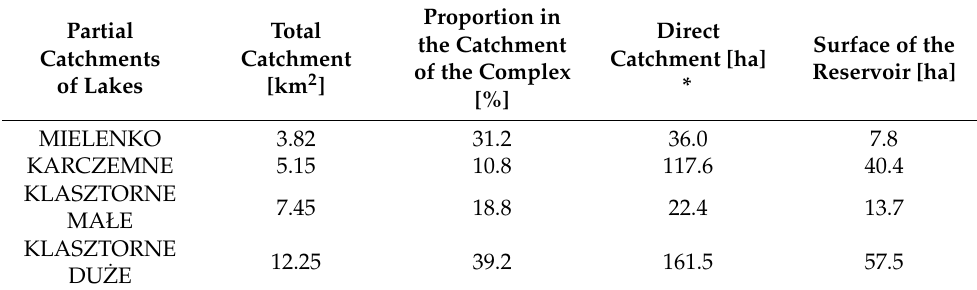
Table 2. Subcatchments of Klasztorne Du˙ze